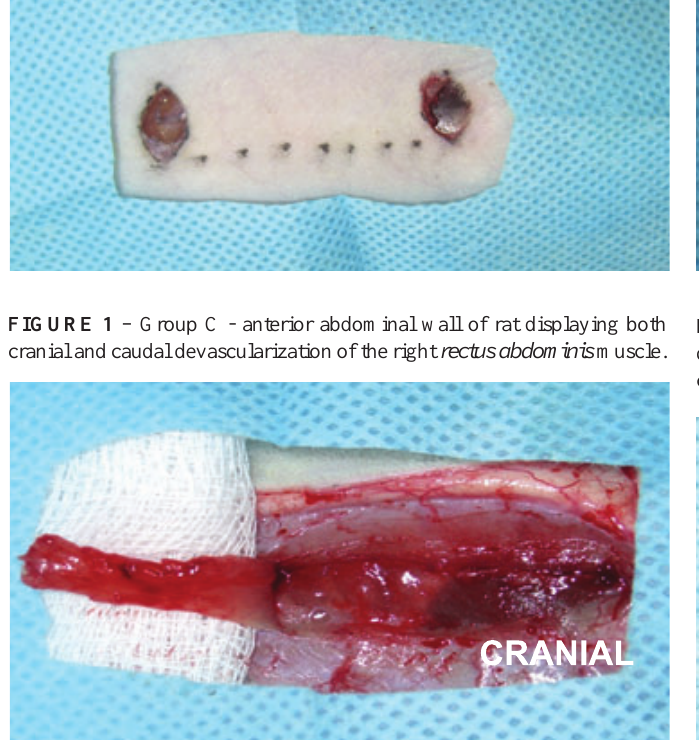
FIGURE 2 – Group D – anterior abdominal wall of rat displaying cranial devascularization of the right rectus abdominis muscle, reflected in the craniocaudal direction.